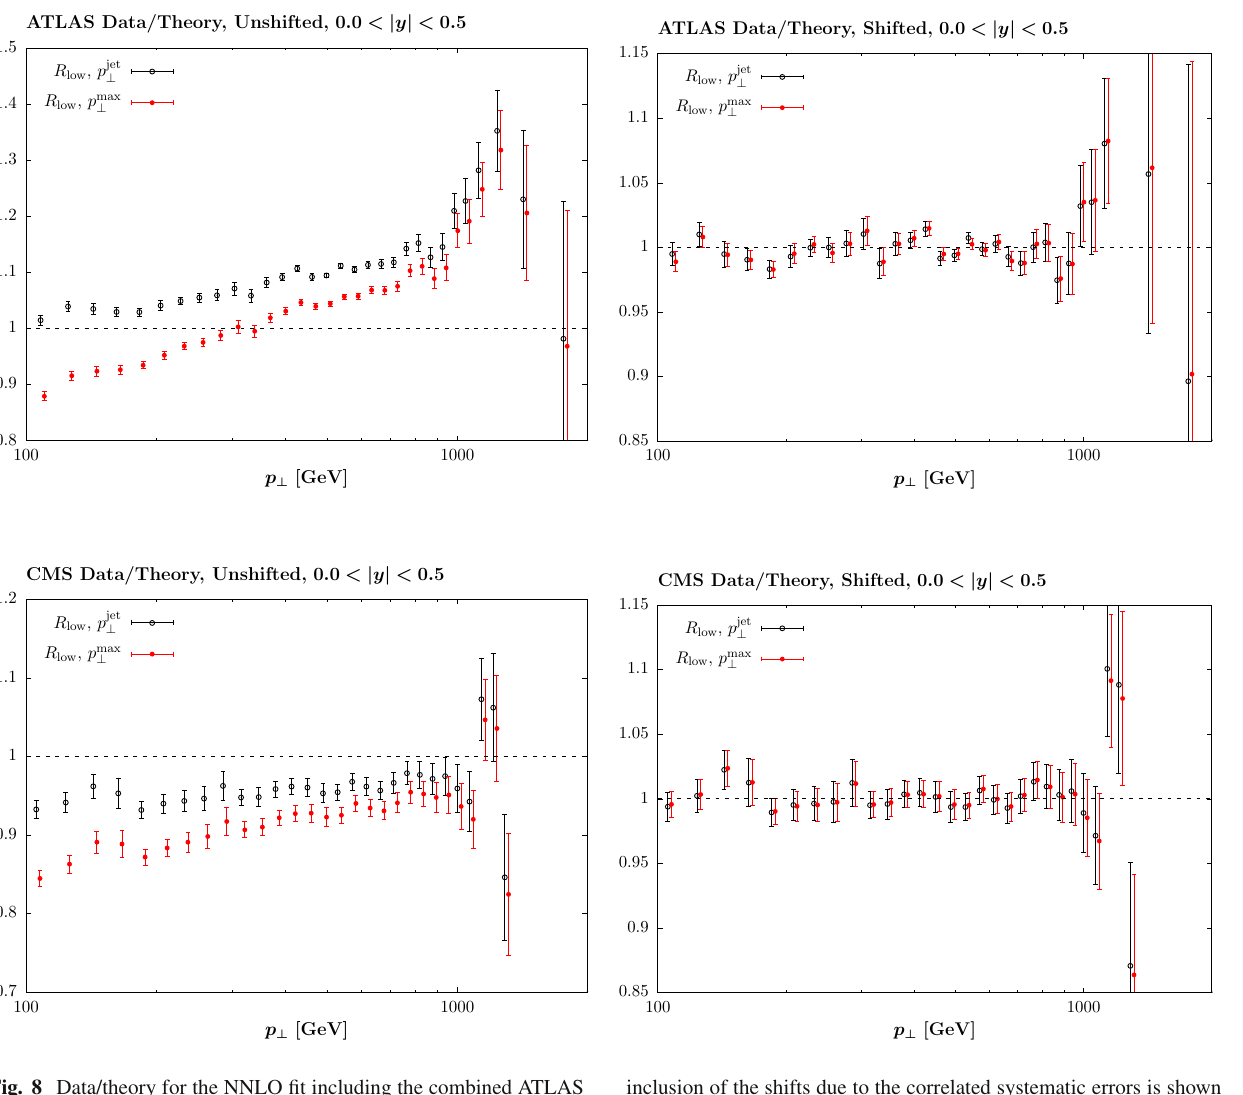
inclusion of the shifts due to the correlated systematic errors is shown in the left and right hand plots, respectively. Statistical errors only are